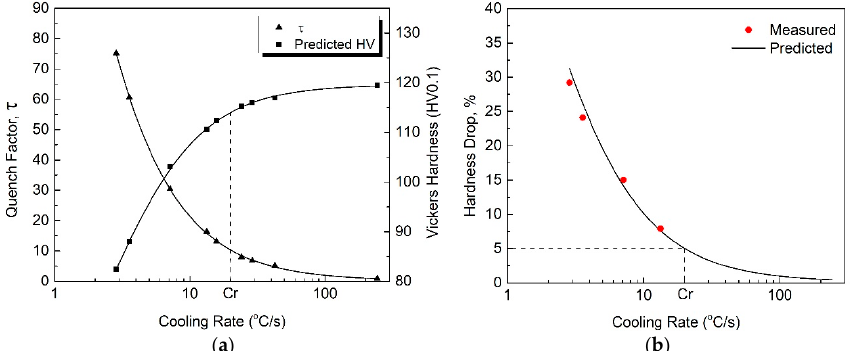
Figure 6. Effect of cooling rate on quench factor and predicted hardness ( a ) and comparison between measured data and predicted hardness decrease ( b ) of HPVD casting samples. Cr is the abbreviation of the critical cooling rate.